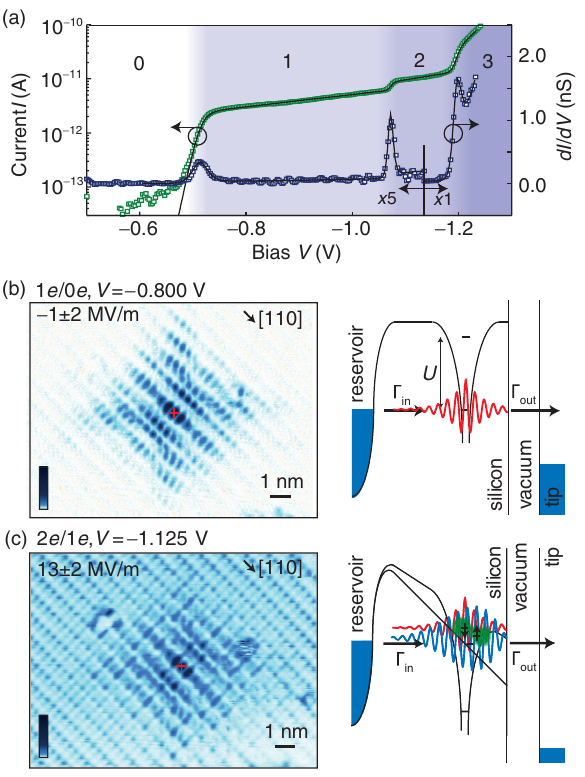
FIG. 2. (a) Bias dependence of current I (green) and conduct- ance dI=dV (blue) over the donor, taken at − 1 . 42 nm in Fig. 1(c), and fit to rate-equation model (black lines). (b) Measured current map of the neutral donor. Right: Tunnel junction energy diagram. (c) Measured current map of coupled donor-QD singlet. Right: Tunnel junction energy diagram. Data for the donor and donor- QD resonances were acquired in the spatial region of the inset of Fig. 1(c). The donor ion position is marked with a red cross. FIG. 3. (a) Donor-QD energy